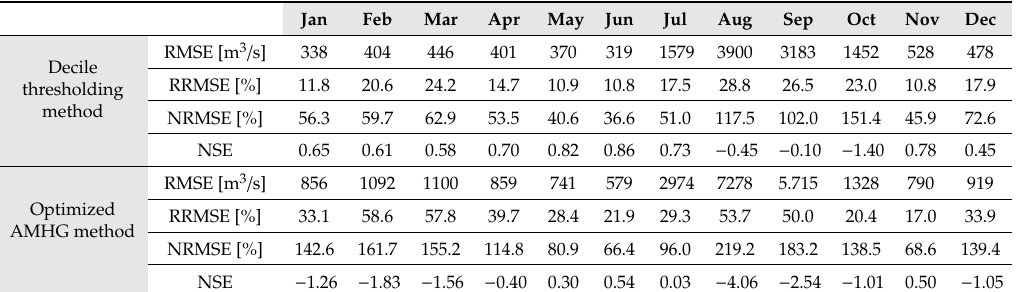
thresholding method and optimized AMHG